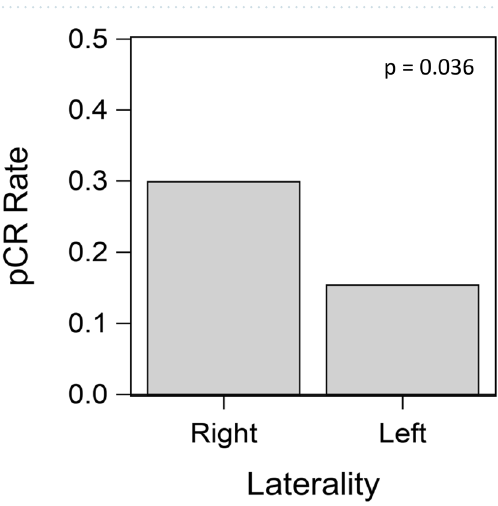
Figure 2. Proliferation related gene sets enriched in Left breast cancer.